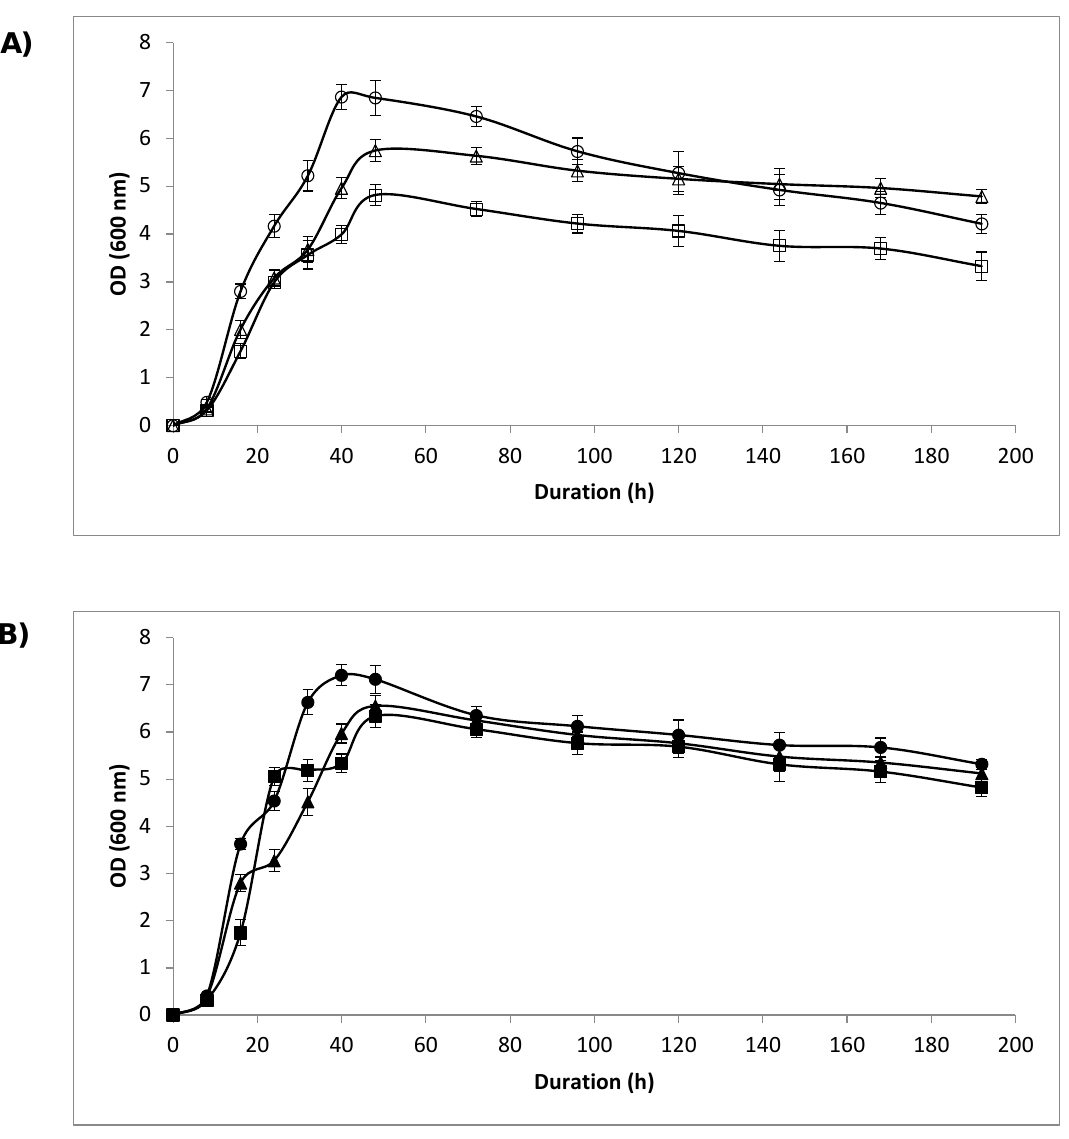
Figure 2. ( A ) OD (600 nm) of non-NaCl-stressed cells during various fermentation times (h) with three different media containing 200, 300, or 400 g/L glucose ( n = 3 replications for each time); ( B ) OD (600 nm) of NaCl-stressed cells during the fermentation process (h) with three different media containing 200, 300, or 400 g/L glucose ( n = 3 replications for each time) ( ): (200 g/L glucose, 0% NaCl), ( ∆ ): (300 g/L glucose, (cid:35) 0% NaCl), ( (cid:3) ): (400 g/L glucose, 0% NaCl), ( ): (200 g/L glucose, 6% NaCl), ( (cid:78) ): (300 g/L glucose, 6% NaCl), ( (cid:4) ): (400 g/L glucose, 6%